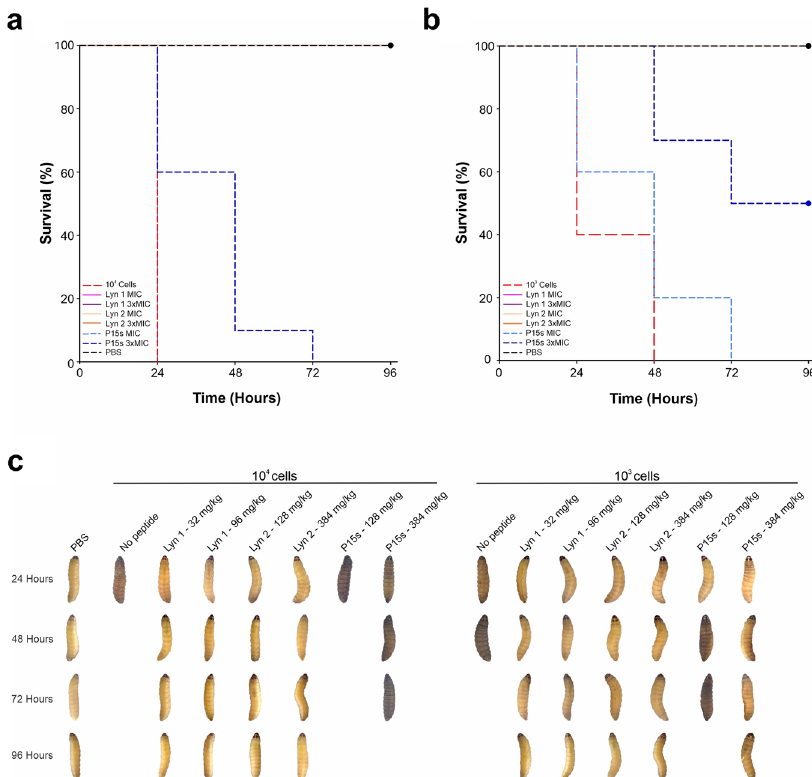
Fig. 8 In vivo ef fi cacy assessment in G. mellonella PAO1 infection model. a Kaplan – Meier survival curves of G. mellonella infected with a 10 4 CFU/larvae. b Kaplan – Meier survival curves of G. mellonella infected with 10 3 CFU/larvae of P. aeruginosa PAO1. c Representative images showing melanisation of larvae treated with the peptides for 96